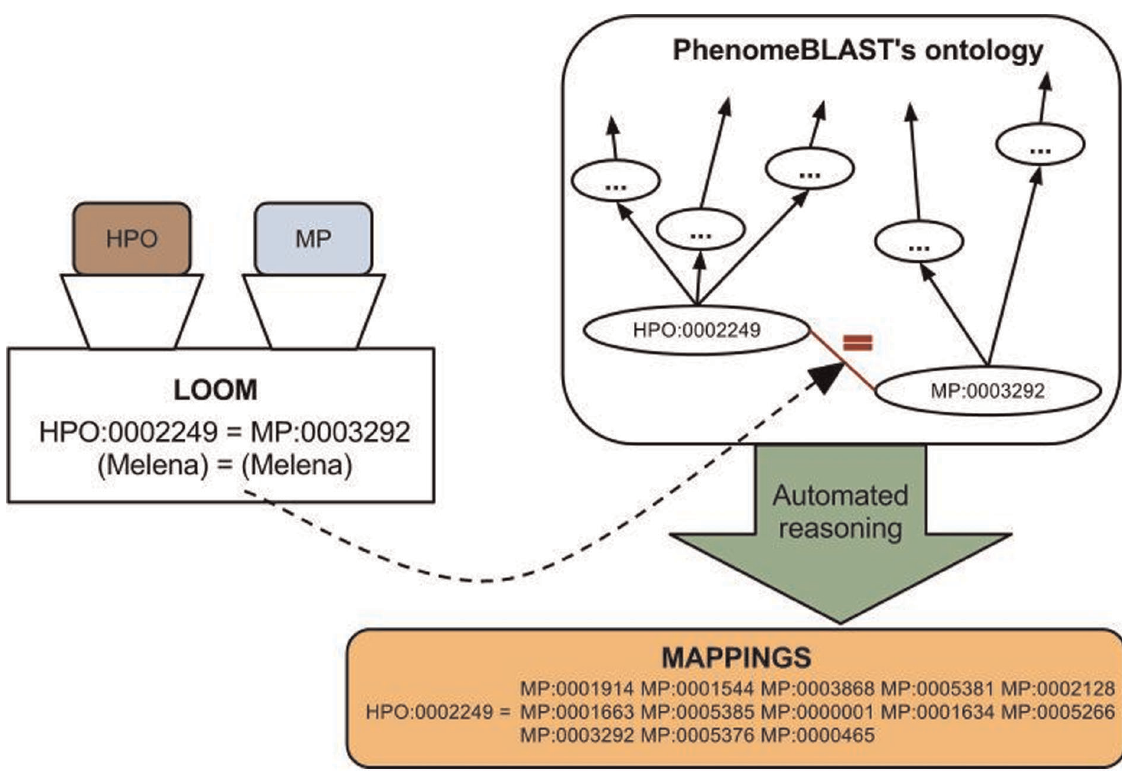
Figure 2. Integration of lexical and ontological mapping. The Lexical OWL Ontology Matcher is applied to the Human and Mammalian Phenotype Ontology to extract lexically matching concepts (based on labels and synonyms). All pairs of lexically matching concepts are inserted as equivalence class axioms into PhenomeBLAST’s ontology. A mapping is generated by reasoning over PhenomeBLAST’s adapted ontology and extracting all equivalence and super classes for each concept.